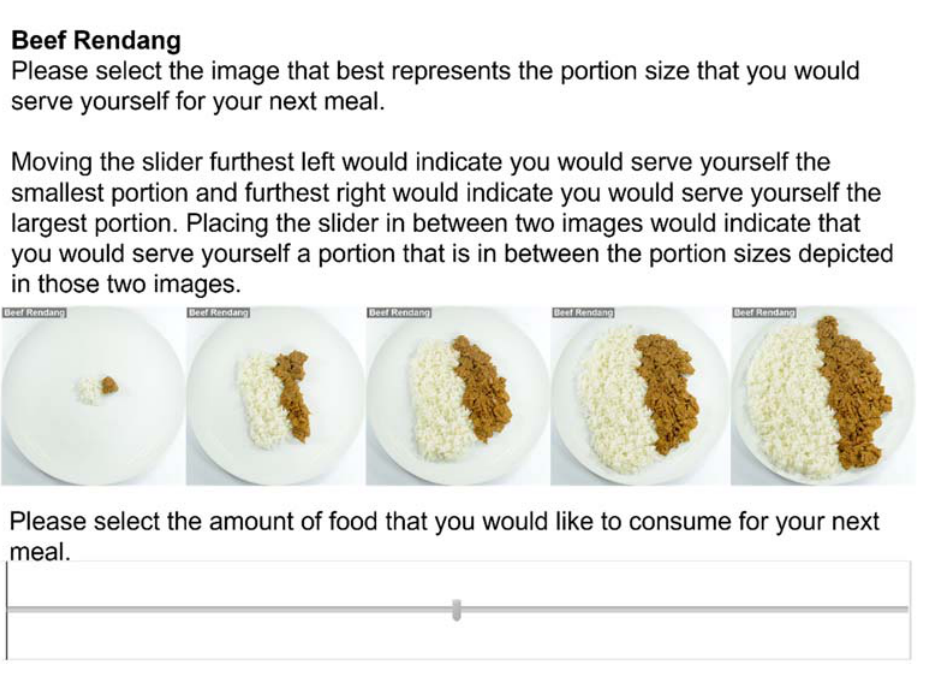
Figure 2. Example of the ‘slider’ version of the simplified portion size task (SPST). Table 1. Corresponding kcal portions presented as images to participants in the SPST and MPST.